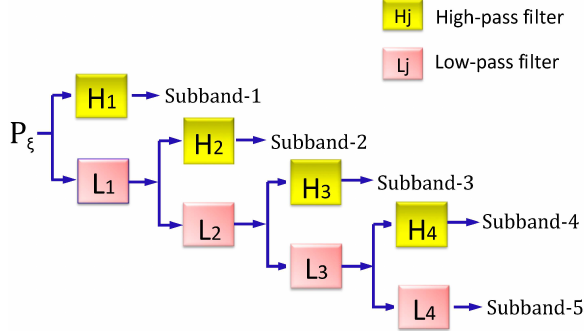
Figure 2. A schematic drawing to illustrate the procedure of multi-level SWT (stationary wavelets transform). See Equations (10)–(12) as well as the relevant text for further